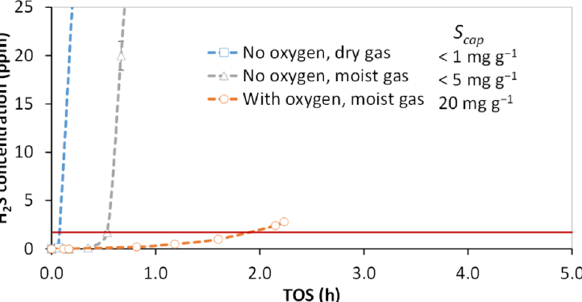
Figure 2. Effect of oxygen and moisture on H 2 S breakthrough with adsorbent impregnated activated carbon (IAC) at a space velocity (SV) of 24,000 h −1 (reactor 1) and H 2 S feed concentration of 100 ppm at 50 ◦ C. Capture capacity, S cap , is indicated as milligrams of sulfur per gram of adsorbent. When oxygen was present the concentration was 3000 ppm, and at moist conditions relative humidity (RH) was set to 50%. Particle size distribution—1.0–1.25 mm. The horizontal red line indicates the breakthrough limit.